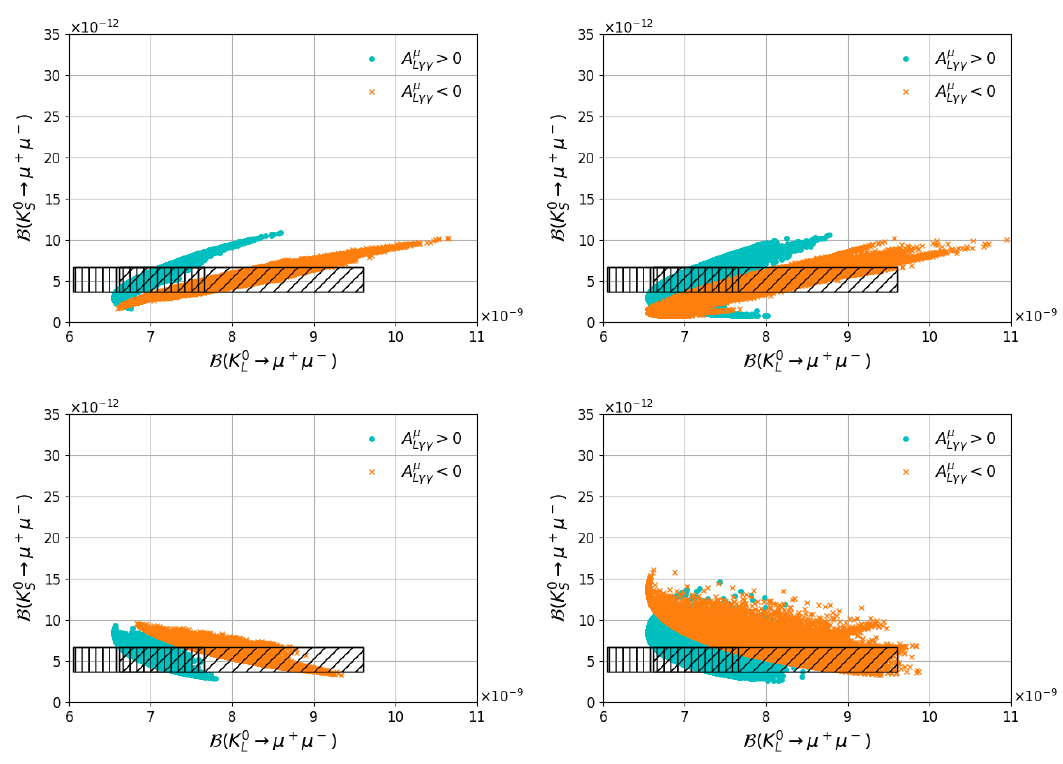
Figure 4 . Scenario B, motivated by Higgsino Dark Matter with universal gaugino masses, B ( K 0 (cid:0) (cid:1) (cid:22) + (cid:22) (cid:0) ) vs. B ( K 0 ! (cid:22) + (cid:22) (cid:0) ) for (cid:14) LL 6 = 0 and ( M 3 (cid:1) (cid:22) ) > 0 (upper left), L d 12 (cid:0) (cid:1) ( M 3 (cid:1) (cid:22) ) < 0 (upper right), (cid:14) RR 6 = 0 and ( M 3 (cid:1) (cid:22) ) > 0 (lower left), and d 12 ( M 3 (cid:1) (cid:22) ) < 0 (lower right). The cyan dots correspond to A (cid:22) A (cid:22) < 0. The vertically hatched area corresponds to the SM prediction for A (cid:22) L(cid:13)(cid:13) inclined hatched area corresponds to the SM prediction for A (cid:22)